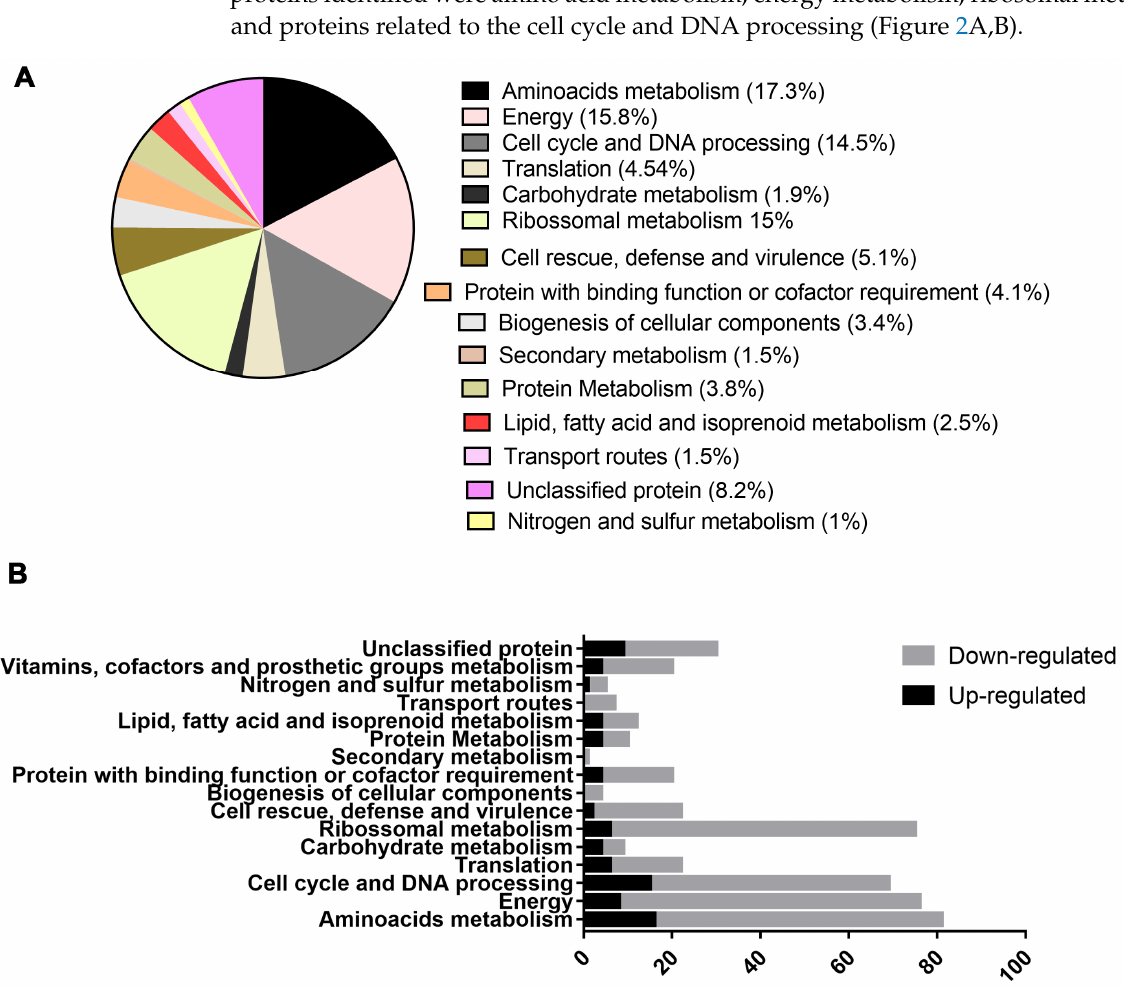
Figure 2. Functional characterization of regulated proteins in P. brasiliensis after exposure to meben- dazole. ( A ) Percentage of regulated protein classes identified by proteomic analysis after exposure to mebendazole, ( B ) comparison of up- and downregulated proteins within the enriched func- tional